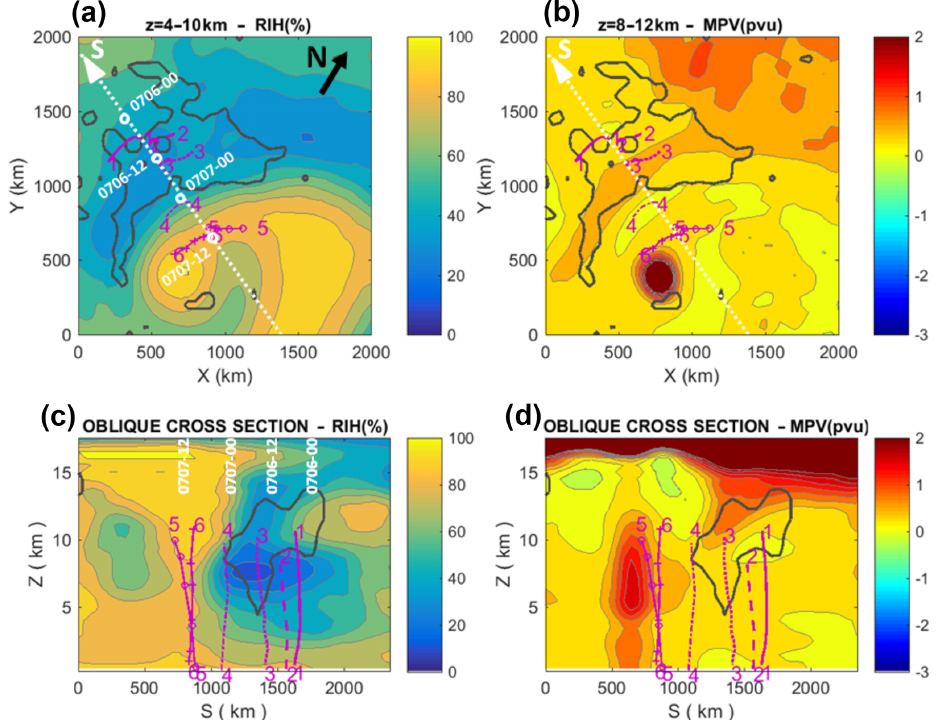
Figure 7. Composites of ERA-5 reanalyses data from 6 July at 00:00UTC to 7 July at 12:00UTC in the domain shown in Fig. 5a. Above are horizontal distributions of (a) relative integrated humidity (RIH) between 4 and 10km altitude (in %) and (b) mean potential vorticity (MPV) between 8 and 12km altitude (inPVU; = 10 − 6 m 2 s − 1 Kkg − 1 ). North is indicated in (a) . The dotted white line ( S axis) represents the pseudo-trajectory of TPE airport in the frame moving with Typhoon Nepartak (successive times are indicated). Below are vertical cross sections of (c) RIH (in %), and (d) MPV (inPVU), averaged across ± 500km along this oblique S line. The solid black contours encompass mean downward velocities < − 1cms − 1 between 6 and 10km altitude. The purple lines 1 to 6 indicate the tracks of IAGOS aircraft during selected take-offs and landings on 6–7